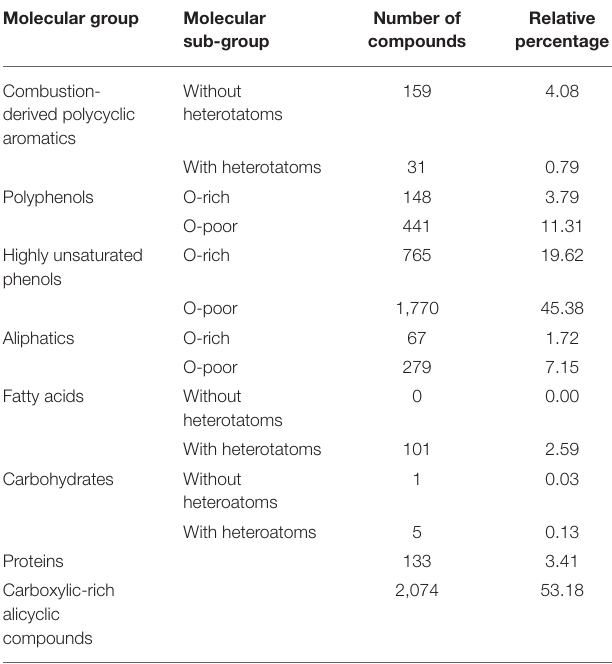
TABLE 1 | Number and percentage of compounds derived from FT-ICR-MS across all the study streams. Molecular group Molecular